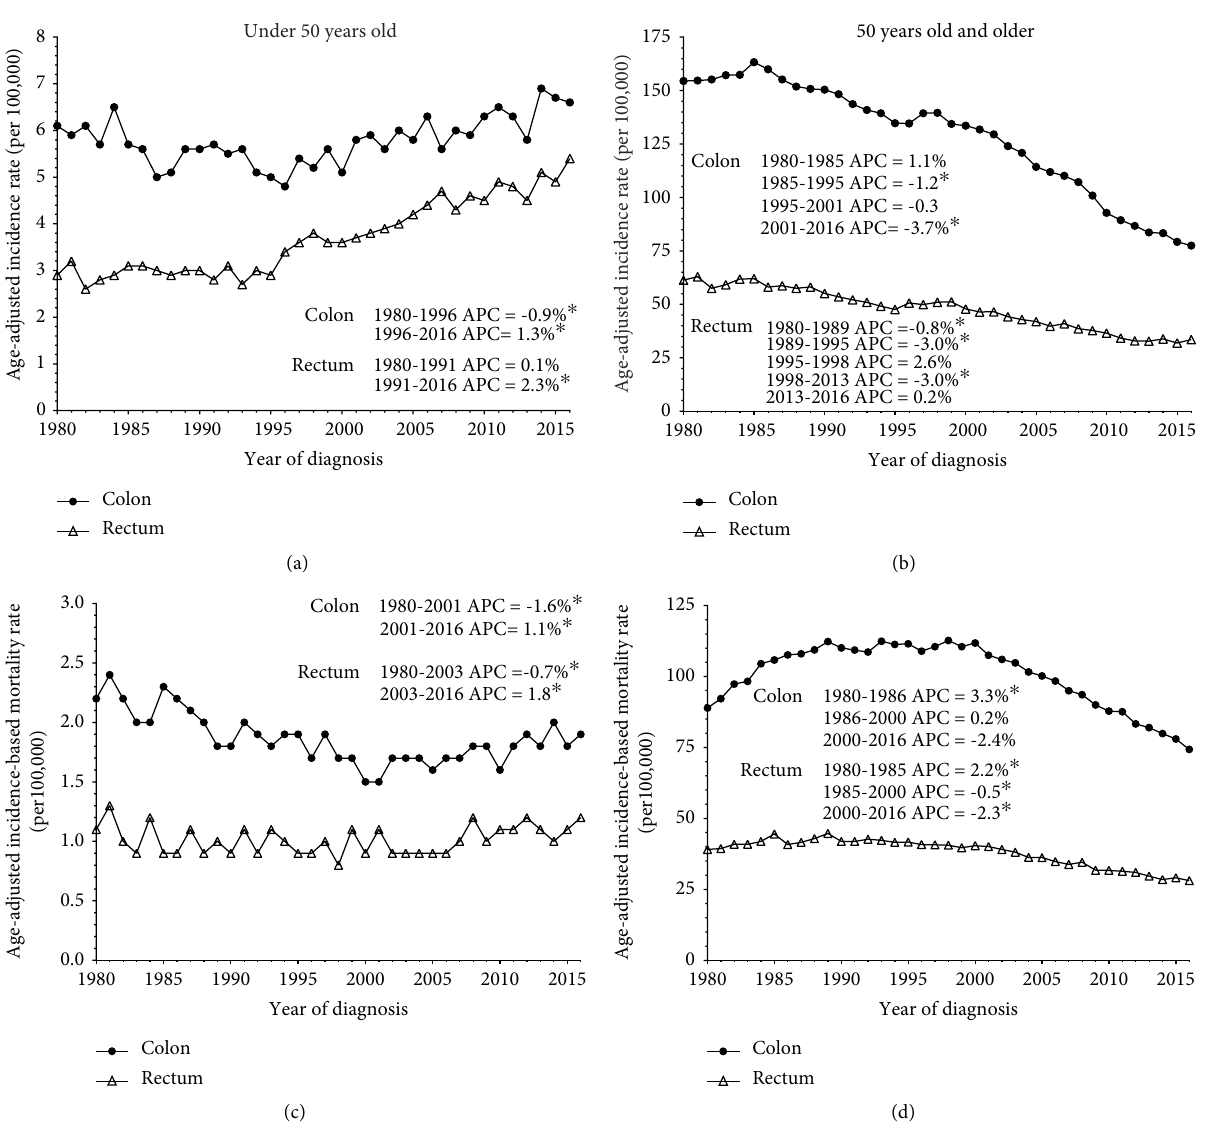
Figure 1: Colon and rectal cancer incidence and mortality rates stratified by age, 1980–2016. Age-adjusted incidence and incidence-based mortality (IBM) rates per 100,000 persons from 1980–2016 were derived from SEER9 program data. Colon and rectal cancer incidence and IBM trends of individuals under the age of 50 (a, c) and age 50 and older (b, d). Annual percentage change (APC) are quantifications of the changes in trends. Asterisks ( ∗ ) designate statistical significance calculated in the permutation